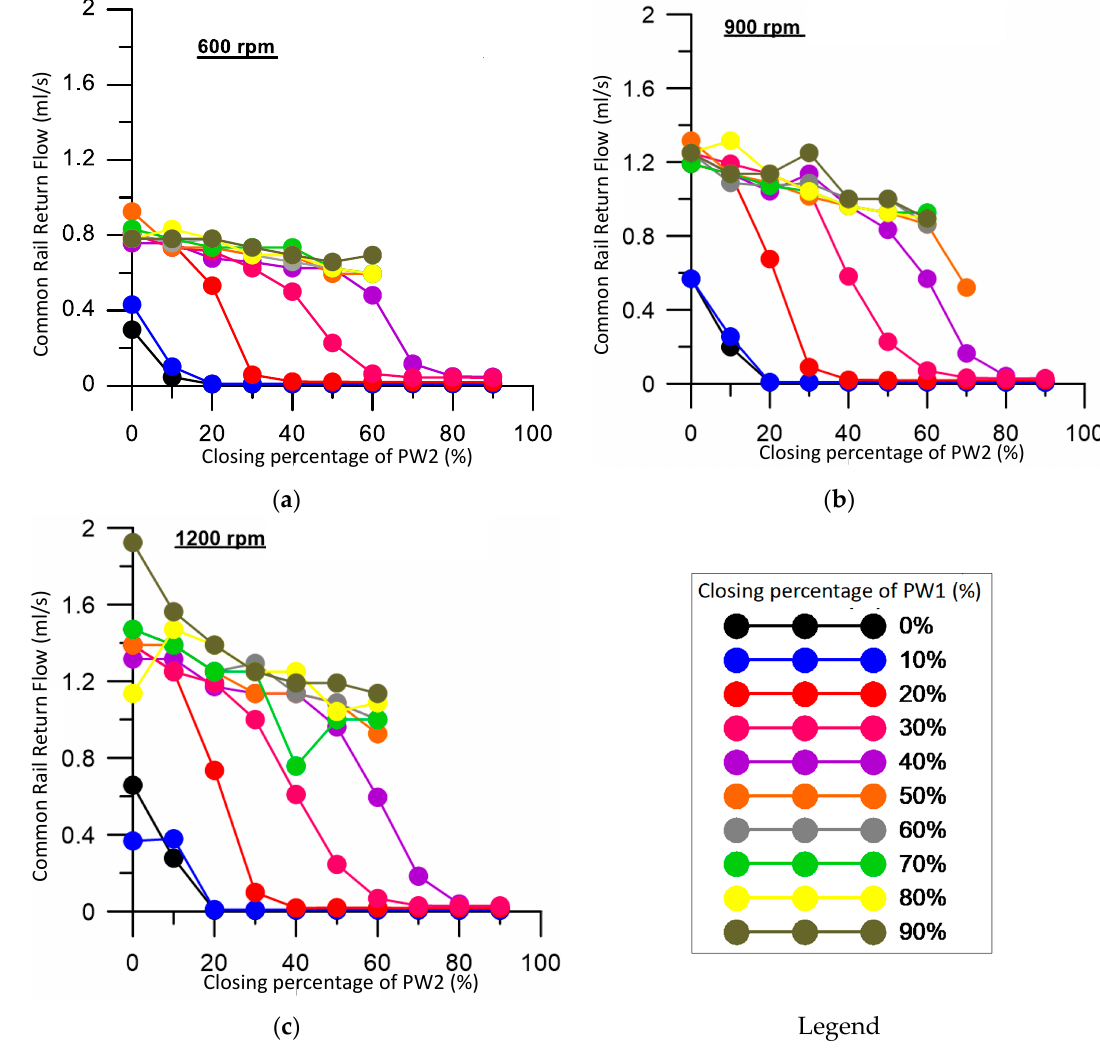
Figure 4. Common rail return flow: ( a ) 600 rpm HPP rotational speed; ( b ) 900 rpm HPP rotational speed; ( c ) 1200 rpm HPP rotational speed.